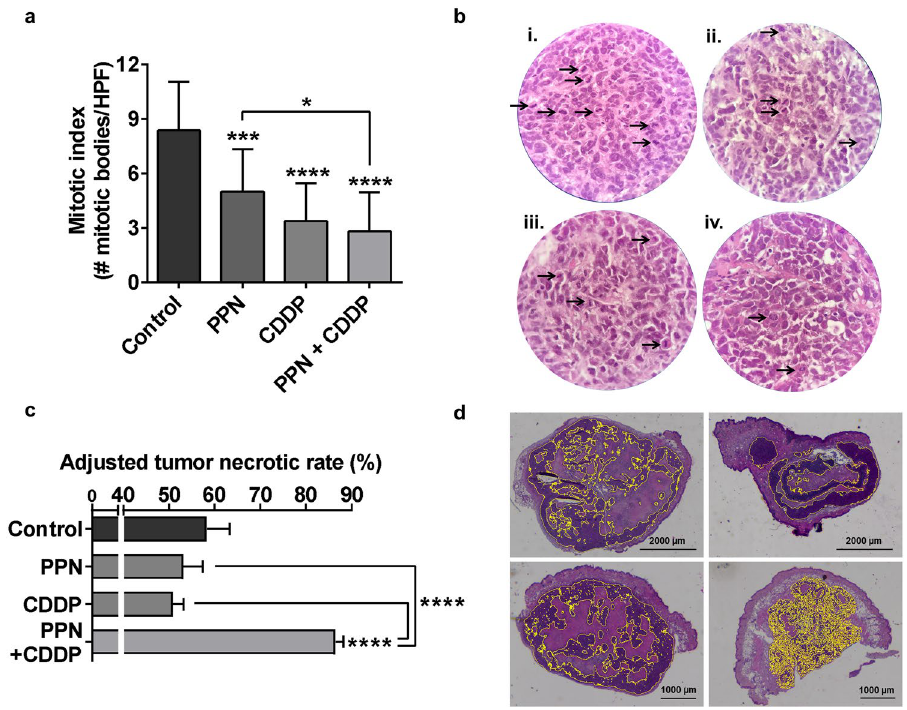
Figure 7. Histopathological assessment of mitotic index and necrosis in osteosarcoma tumors after treatment. ( a ) Antimitotic activity of propranolol (PPN) in combination with metronomic cisplatin (CDDP) on osteosarcoma (OSA) xenografts. Quantification of mitotic index in OSA tumor sections from different experimental groups was expressed as the number of mitotic bodies per HPF. ( b ) Representative images of H&E stained tumor slides belonging to animals treated with i) vehicle, ii) PPN, iii) CDDP or iv) PPN plus CDDP. Arrows show tumor cell mitotic bodies (×400 magnification). ( c ) % of tumor necrosis in OSA samples was adjusted to tumor volume variation as a response to specific treatments, and was expressed as adjusted tumor necrotic rates. ( d ) Representative digitally-stitched images of complete tumor sections from vehicle (upper left), PPN (upper right), CDDP (lower left) and PPN plus CDDP (lower right) treatment groups. Yellow lines in tumor slides mark highly basophilic tissue regions belonging to viable malignant tissue. Scale bars = 1000